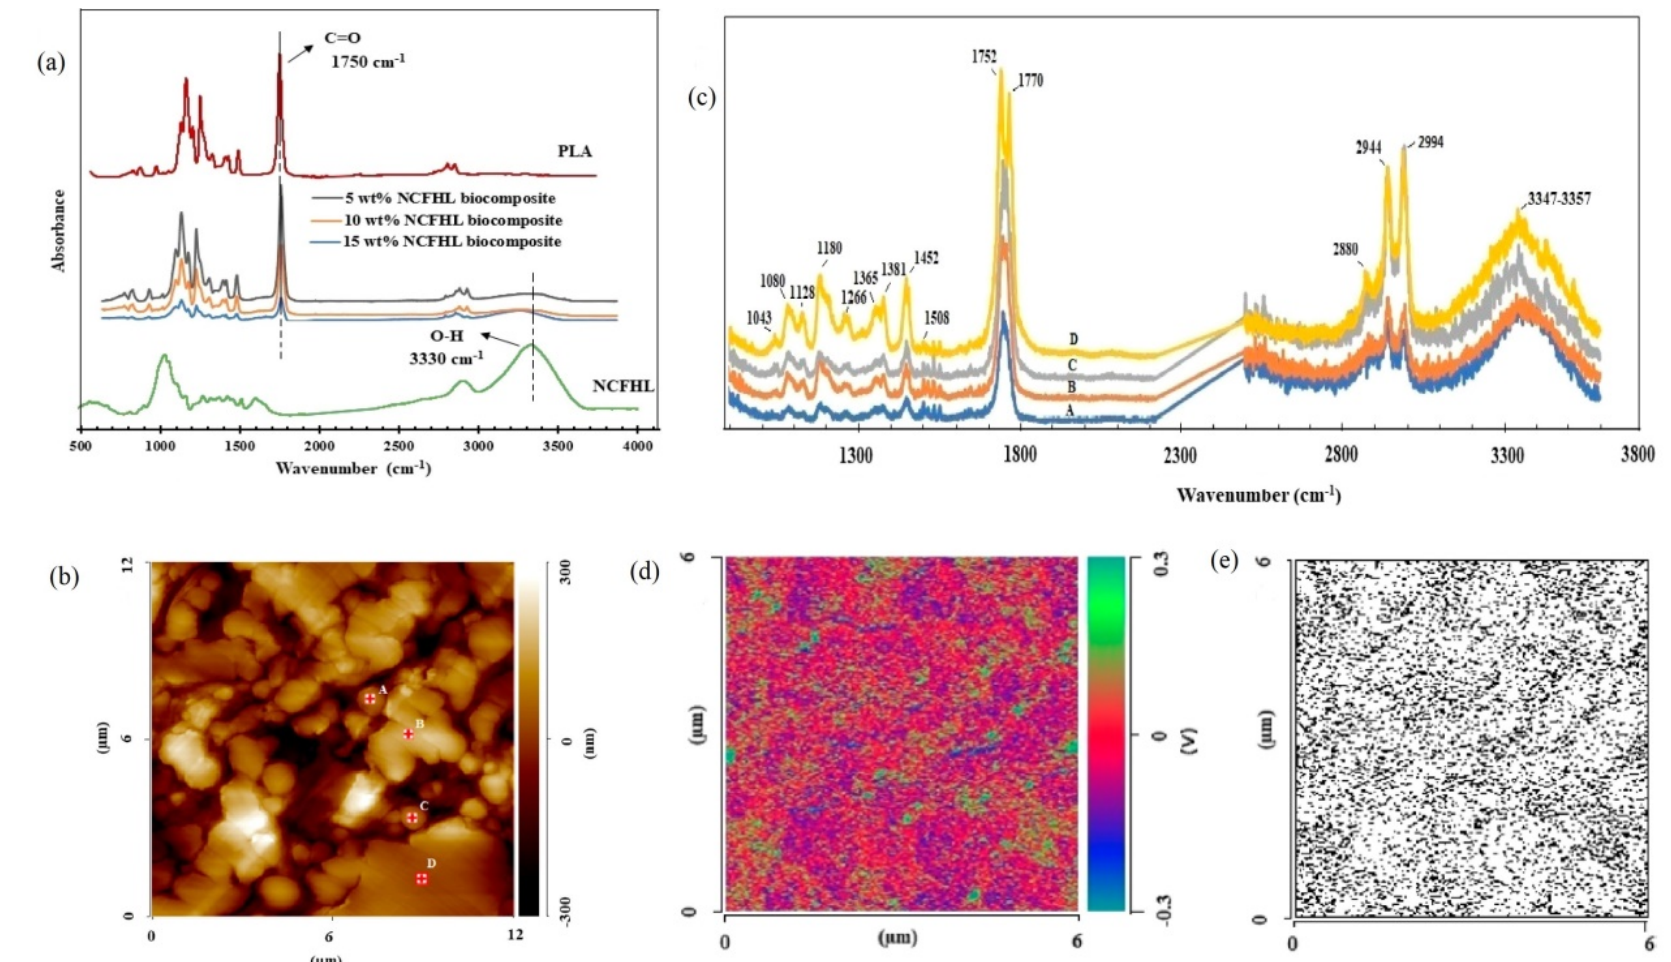
Figure 4. ( a ) Bulk FTIR spectra for nanocellulose fibrils, neat PLA, and their nanocomposites ( b ) AFM topography image of the nanocomposites ( c ). Corresponding NanoIR spectra obtained for areas in ( b ). ( d ) NanoIR (Anasys Instruments, Santa Barbara, CA, USA) images with the IR laser at 3330 cm − 1 (nanocellulose fibrils characteristic peak), and its corresponding binary image ( e ). Reproduced with permission from [51]. Copyright American Chemical Society,